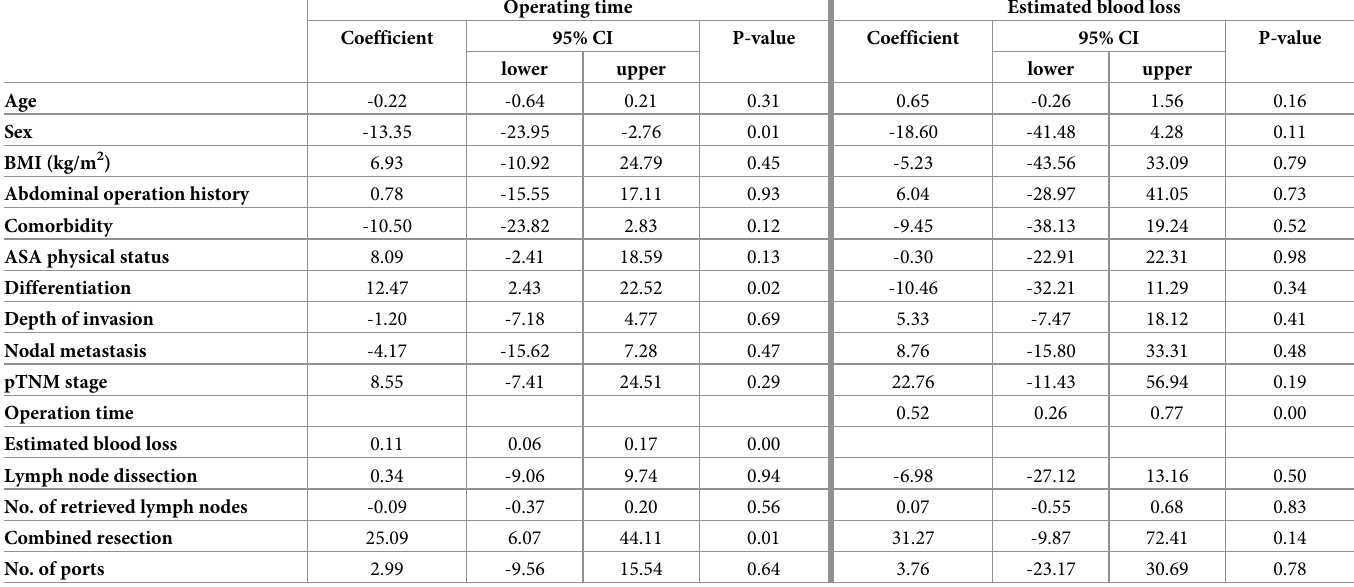
Table 3. Multivariate logistic regression analysis of operative